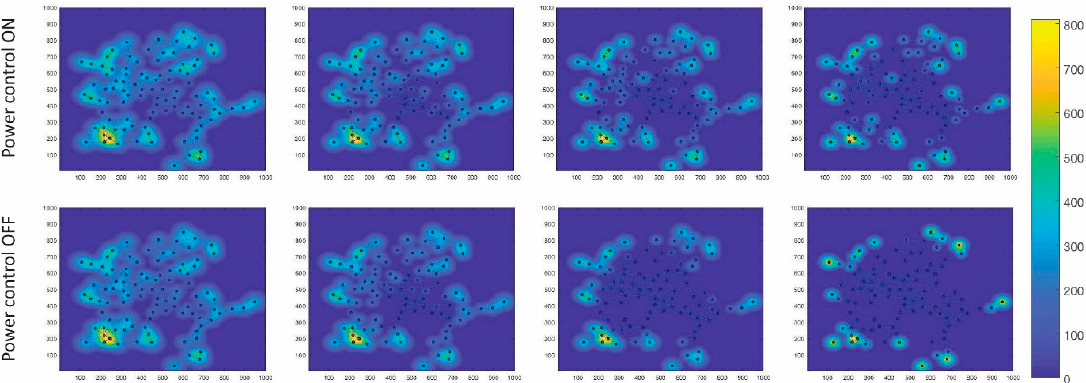
Figure 1. Network power level heatmap demonstrating the changes in the nodes power level in four stages of the running